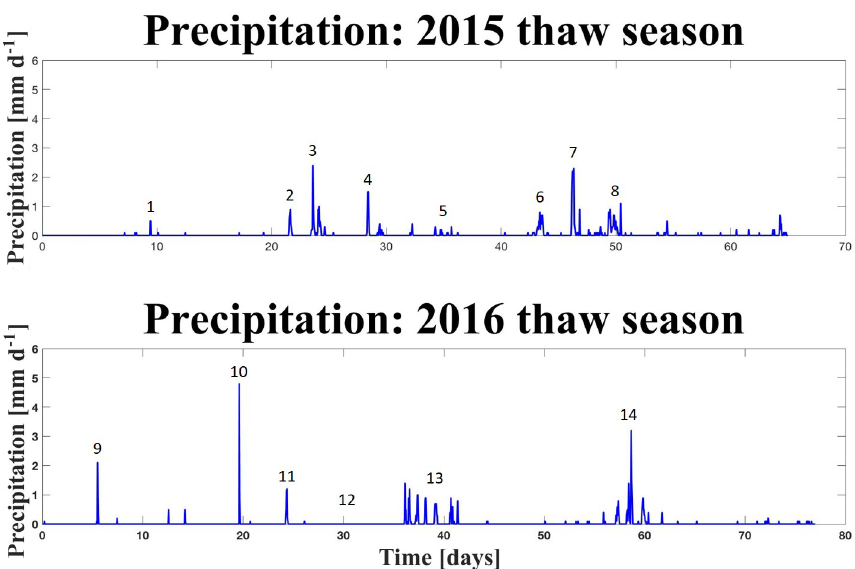
Figure 5. Precipitation events, from 3 July 2015 to 30 September 2016, used in the calculation of characteristics of well response. Note that event 12 is not a precipitation event, but marks where a recession limb was analyzed for each